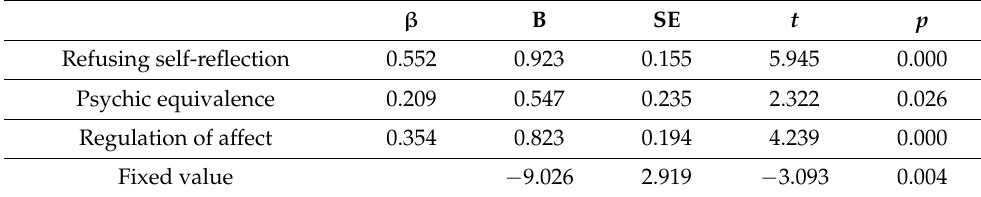
Table 7. Predictors of anxious